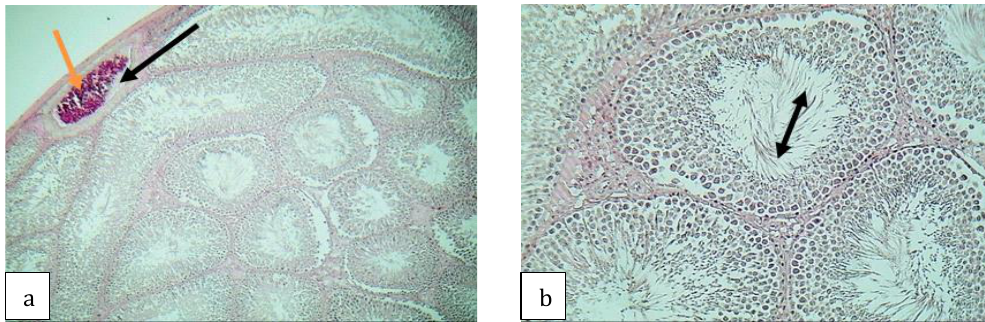
Figure 5. A photomicrograph of the right testis of an adult male Wistar rat received H 2 O 2 plus resveratrol (G2) showing a) edema (black arrow) and subscapular congestion (red arrow). (H&E, 100×), b) active sperms in the tubules (arrow) (H&E,